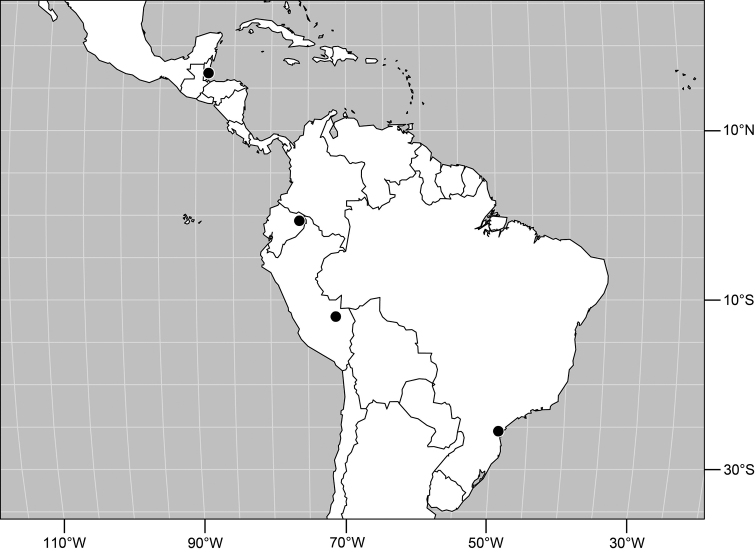
Distribution of Polytrichophora prolata sp. n.